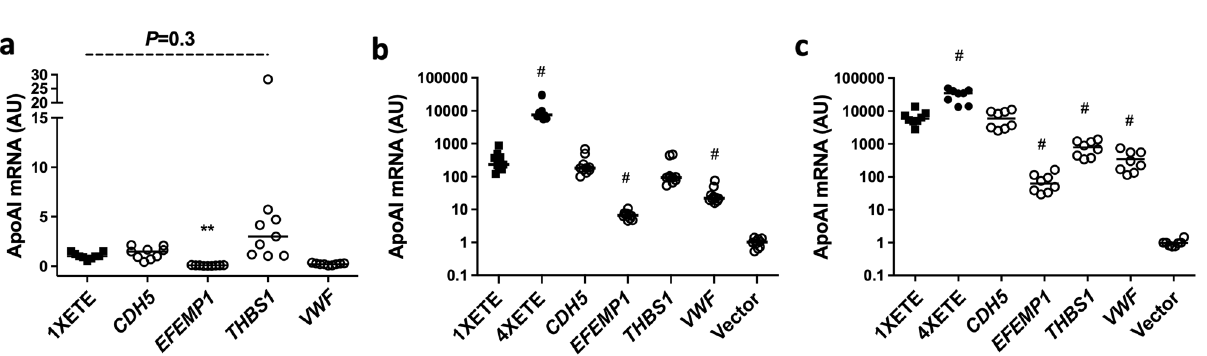
Figure 6. Expression of APOAI from genomic regions associated with highly expressed transcripts in cultured endothelial cells. ( a ) Bovine aortic endothelial cells were transfected with pBshuttle-1XETE-gApoAI-oPRE (1XETE) or with plasmids containing the rabbit APOAI gene inserted into genomic regions of CDH5 , EFEMP1 , THBS1 , or VWF (see Supplemental Fig. S2). ( b ) Human aortic endothelial cells or ( c ) human umbilical vein endothelial cells were transfected with the same plasmids as in ( a ). Cells in ( b , c ) were also transfected with pBshuttle (vector), a plasmid that does not express APOAI . ( a – c ) APOAI mRNA was measured by RT-qPCR, 24 h after transfection. Data are from three independent experiments; bars are group medians. Median APOAI expression for 1XETE ( a ) or empty vector control ( b , c ) is assigned a value of 1; all other points are measured relative to this value. ** P < 0.01; # P < 0.005 vs.